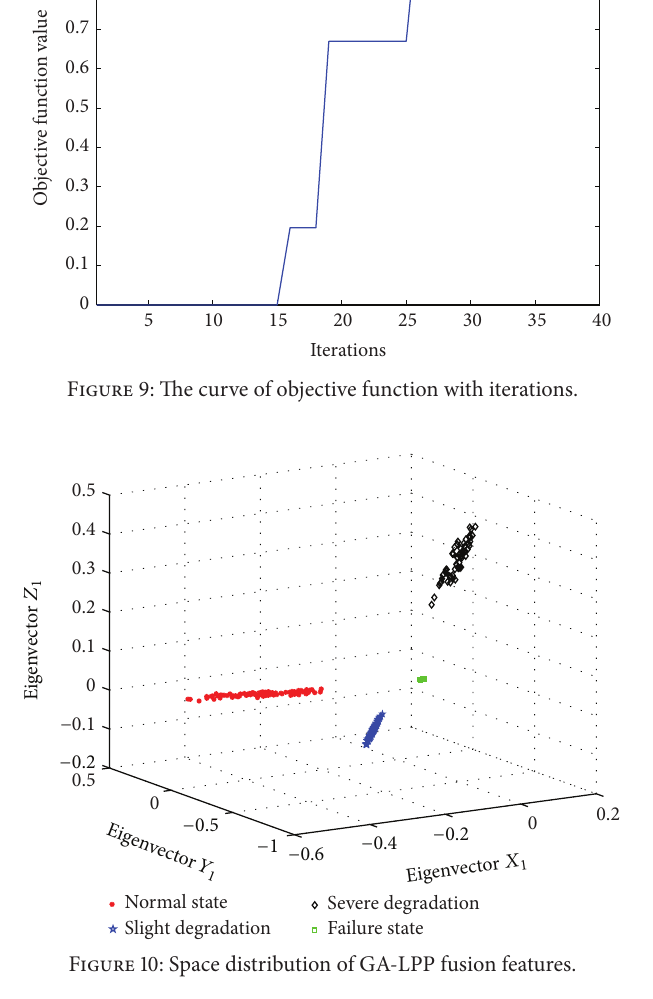
feature points. In comparison with Figure 8, the optimized